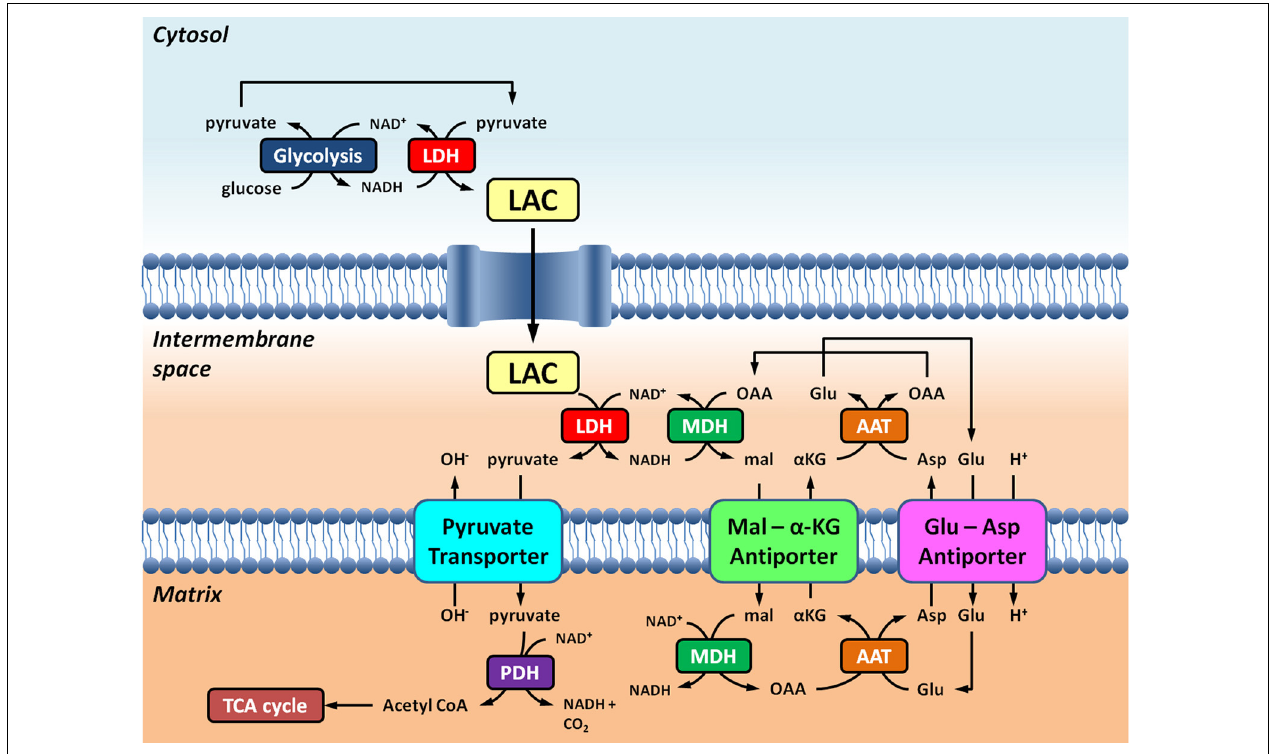
FIGURE 1 | Schematic representation of the link between glycolysis and lactate oxidation at the mitochondria outlined in this Perspective. Overall, glycolysis yields pyruvate and NADH, in addition to ATP. NAD + can be regenerated for glycolysis by the reduction of pyruvate to lactate (LAC) by lactate dehydrogenase (LDH). LAC can diffuse to the mitochondria where it is oxidized to pyruvate by LDH.